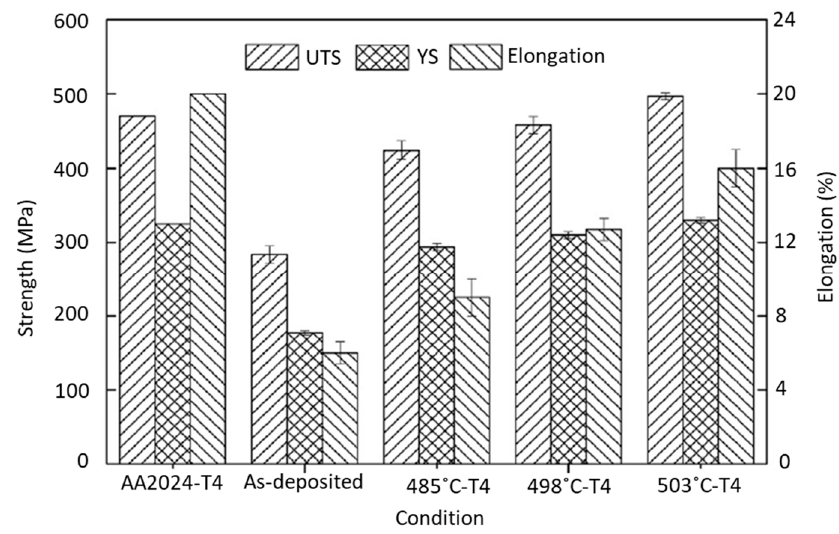
Figure 27. Tensile properties of 2024 aluminum samples [129].